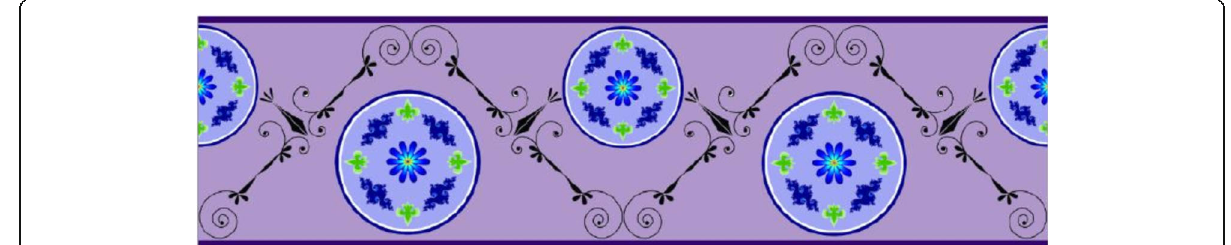
Fig. 13 The two-dimension series corrugated-type